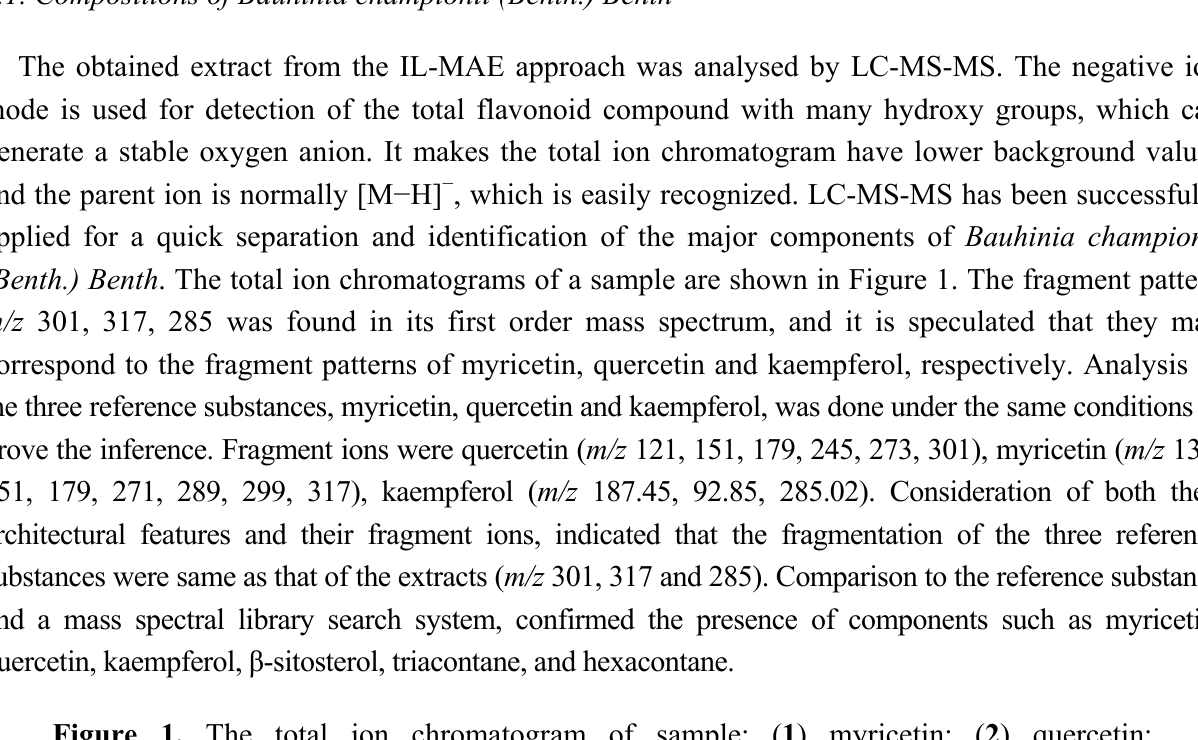
Figure 1. The total ion chromatogram of sample: ( 1 ) myricetin; ( 2 ) quercetin; ( 3 )